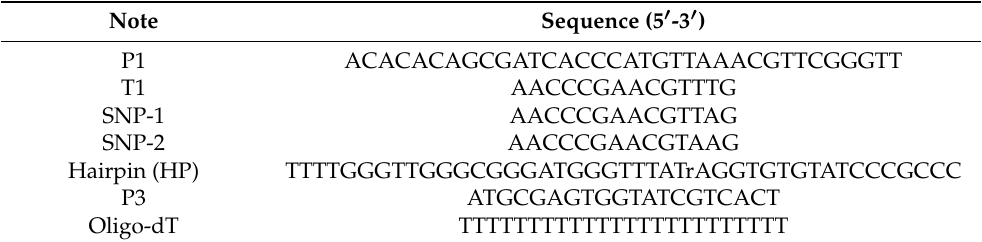
Table 1. Sequence of oligonucleotides designed in the present